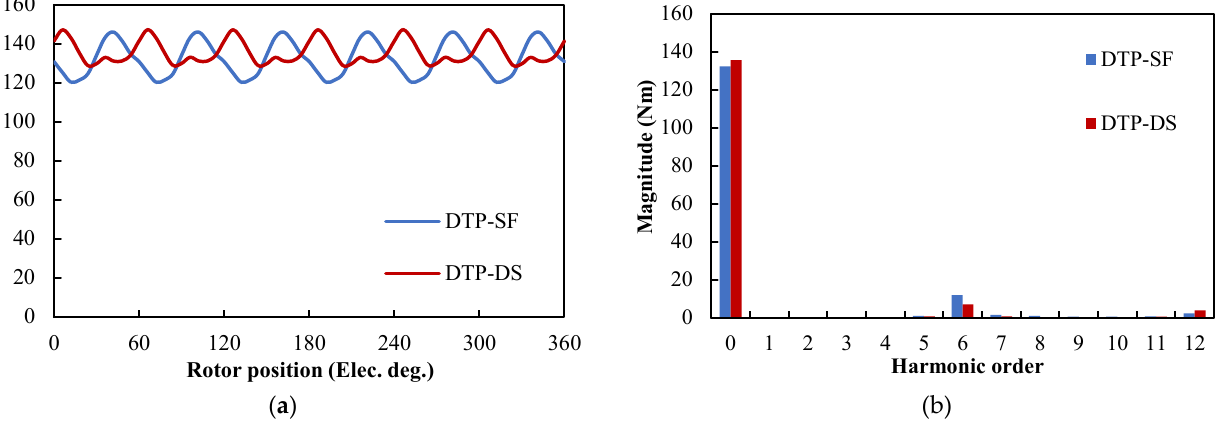
Figure 37. Instantaneous torque characteristics of different winding configurations under three-phase OC maximum torque condition: ( a ) waveforms; ( b ) spectra. Table 9. Comparison of instantaneous torque characteristics of different winding configurations under the three-phase OC maximum torque condition.